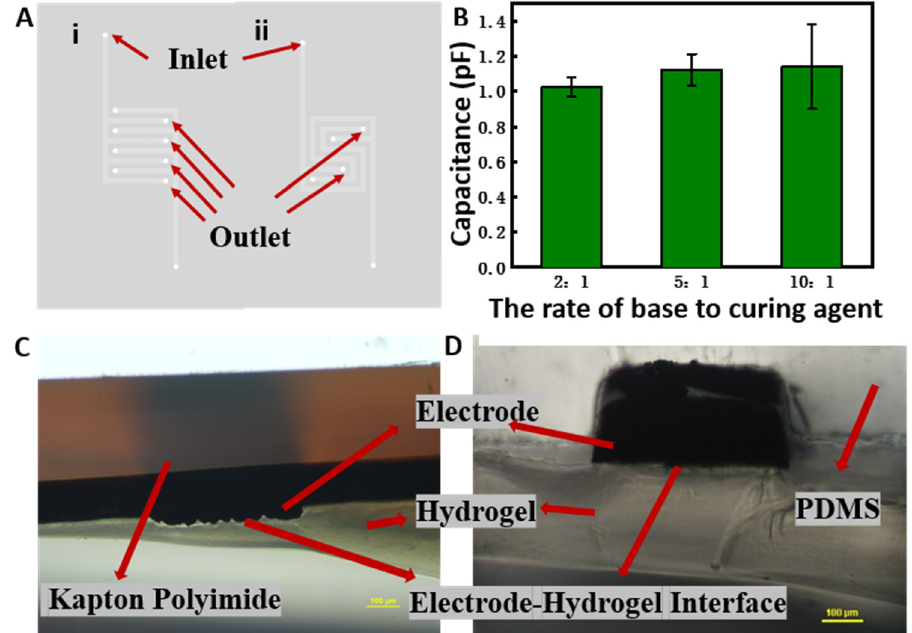
Figure 2. ( A ) Schematic illustration of fabricated interdigital and serpentine electrodes with PDMS microfluidic channels. ( B ) Air capacitance of an SRE fabricated using PDMS microfluidic channels with different proportions of base and curing agent, where the error bars reflect standard errors.